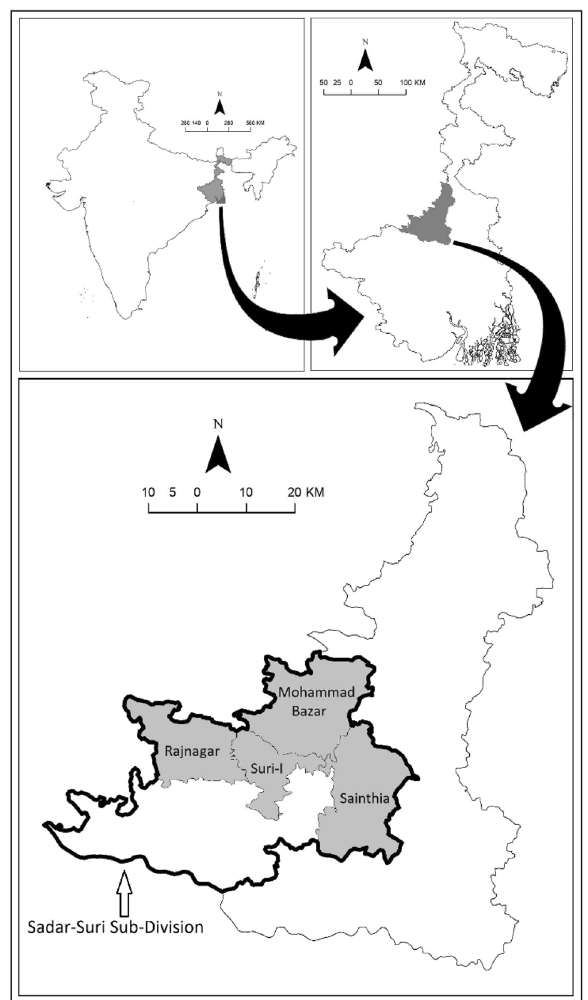
Figure 1. Study area of the Birbhum Population Project, Society for Health and Demographic Surveillance. Figure was developed using ArcGIS Software, Release 10: https:// www. arcgis.